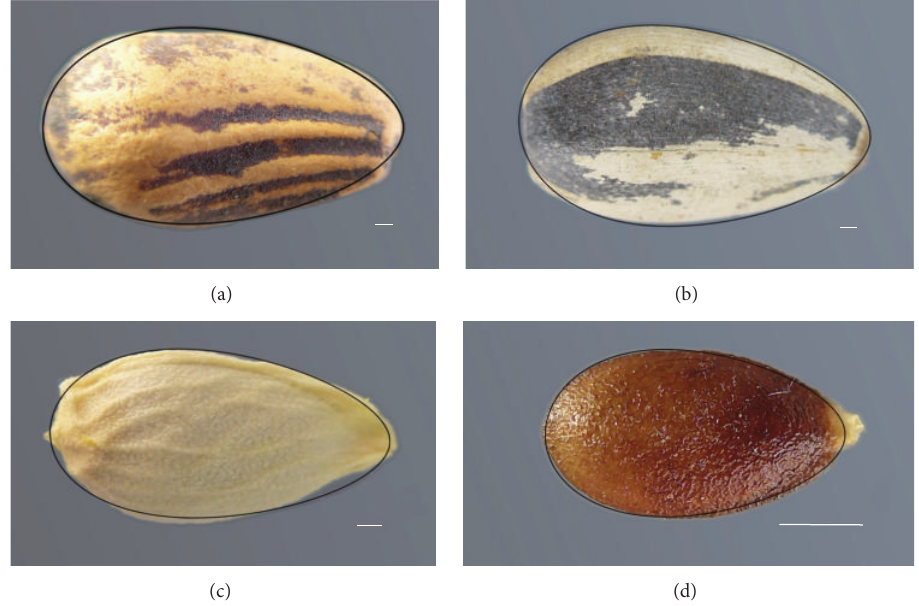
Figure 6: Seed shape models based on the ovoid may be used for the Pinaceae ((a) Pinus pinea L.), Asteraceae ((b) Helianthus annuus L.), Rutaceae ((c) Citrus reticulata Blanco), and Cucurbitaceae ((d) Ecballium elaterium L.). Scale bar represents 1